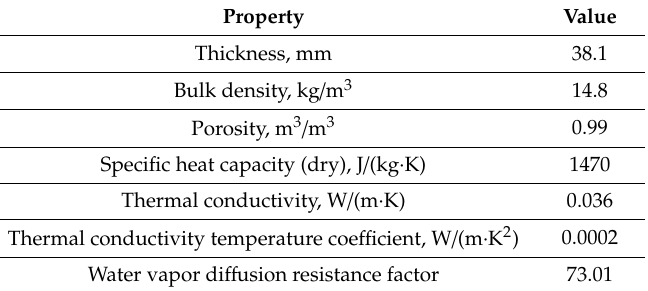
Table A5. EPS property